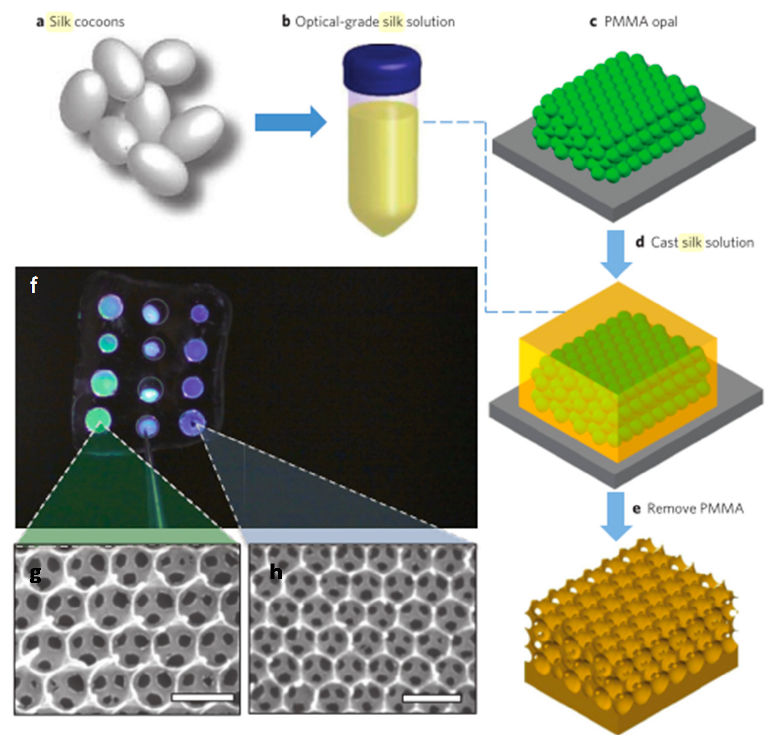
Figure 9. ( a – e ) Fabrication process for a sik inverse opal. ( f ) Green and blue silk inverse opals and ( g,h ) their corresponding SEM images [101]. ( g,h ) their corresponding SEM images